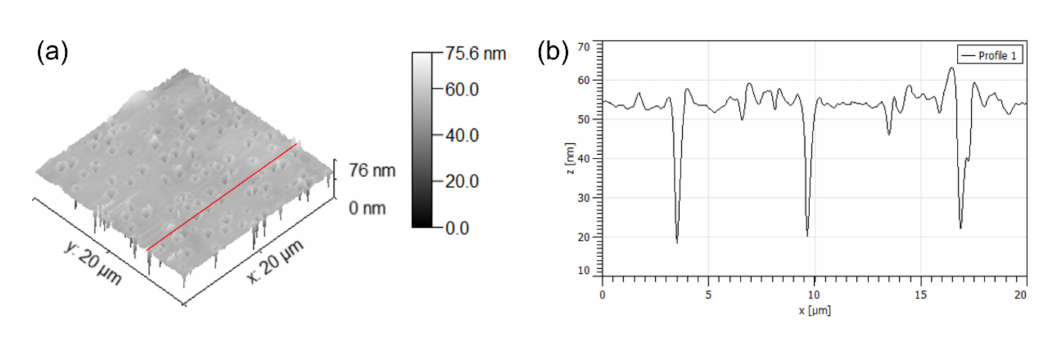
Figure 11. ( a ) Three-dimensional AFM image and ( b ) profile of the thiol-ene surface imprinted at room temperature under 30 MPa for 70 h. The red line indicates the location where the AFM profile was